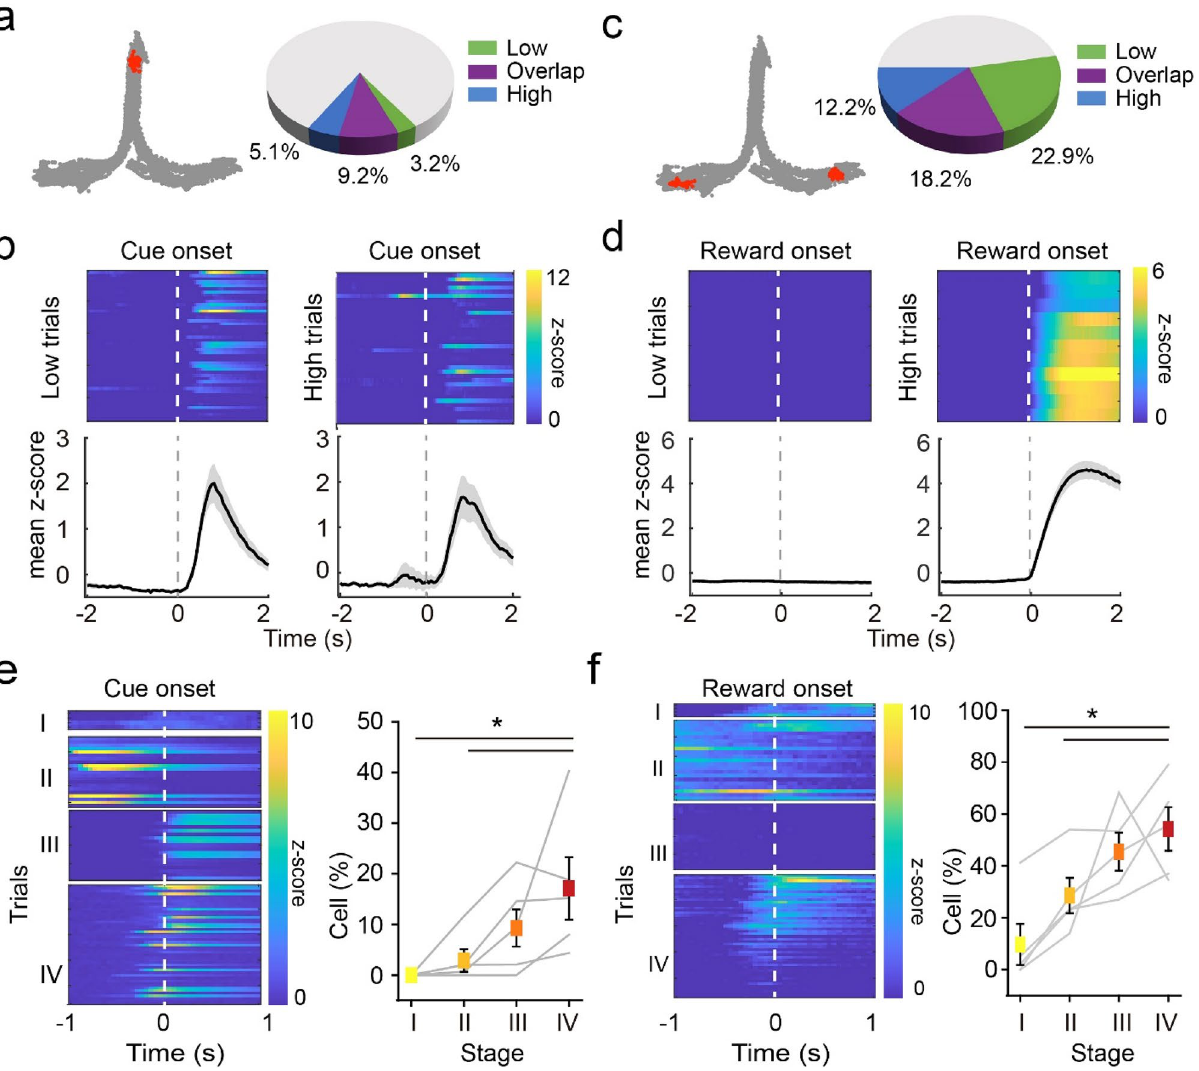
Figure 3. DGC encodes task-related variables in the auditory task. ( a ) Left, example behavioral trajectories (gray) and location at cue onset (red). Right, composition of low and high trial-responding and overlapping cells. ( b ) Example cell that presented higher Ca 2+ signal post-cue onset in both low (left) and high (right) trial. Top, z-scored Ca 2+ intensity aligned to cue onset in each trial. Bottom, trial-averaged z-score. ( c ) Left, example behavioral trajectories (gray) and location at reward onset (red). Right, composition of low and high trial- responding and overlapping cells. ( d ) Example cell that presented higher Ca 2+ signal post-reward onset in high but not in low trials. Top, z-scored Ca 2+ intensity aligned to reward onset in each trial. Bottom, trial-averaged z-score. ( e ) The emergence of cue-onset cells over the course of learning. Left, example cell that was not cue- responding in early learning process but emerged to be active in later RS. Right, percentage of cue-responding cells in each RS (n = 5 rats, mean ± SEM, Kruskal–Wallis test, * P < 0.05). ( f ) The percentage of reward-onset cells increased across learning. Left, example cell that was not responding to reward or anticipating reward but emerged to be active near the reward location in later RS. Right, percentage of responding cells in each RS (n = 5 rats, mean ± SEM, Kruskal–Wallis test, * P < computed Pearson’s correlations between non-averaged fluorescence intensity from each pair of cells in cor- rect trials of each trial type. Most pairs (73.5% for low and 66% for high trials) showed small correlation coef- ficients (r < 0.2). This suggests that cells were activated at different time points within trials and thus may fire in a sequential pattern throughout the trial. Indeed, the z-scored, trial-averaged Δf/f of place-coding DGCs had peak signals at different time points, and the cross-validated sequential activity covered the entire trial from cue onset to reward onset (Fig. 4a,b). Place-coding DGCs in one trial type did not exhibit the sequential pattern in the other trial type (Fig. 4a,b and Supplementary Fig. 4a–f), suggesting that this sequential pattern is not simply encoding timing and distinct DGC ensembles participate in different auditory-cued decisions. Similarly, we found trial type specific sequential DGC activity over the rat’s physical linearized location in the maze (Sup-